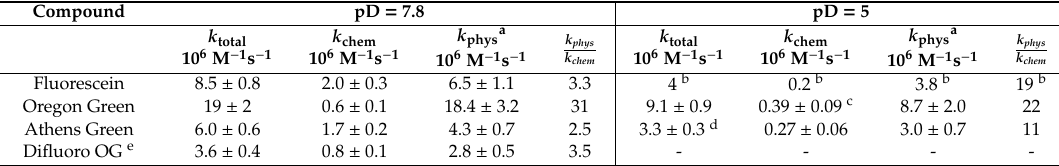
Table 5. Rate constants for the interaction with O 2 (a 1 ∆ g ) measured at two di ff erent pD values in air-saturated solutions.